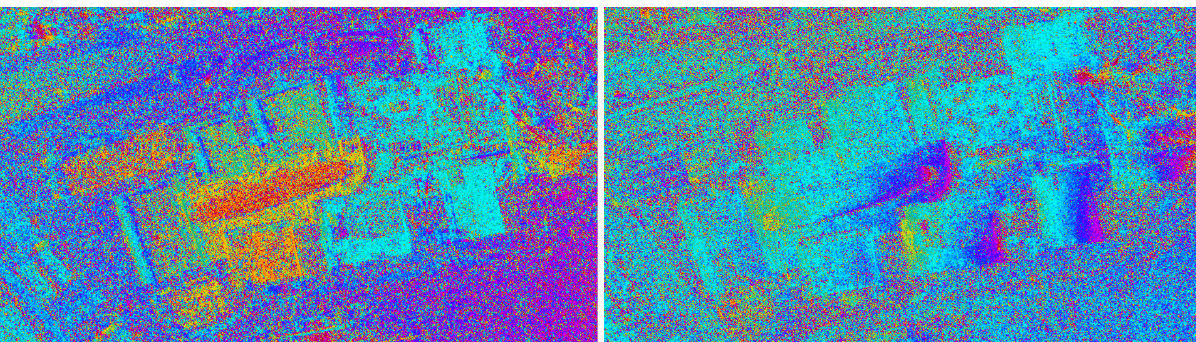
Figure 3. Comparison of single-pass TanDEM-X interferogram (left) and repeat-pass TerraSAR-X interferogram generated from two images with a time lag of 33 days (right).